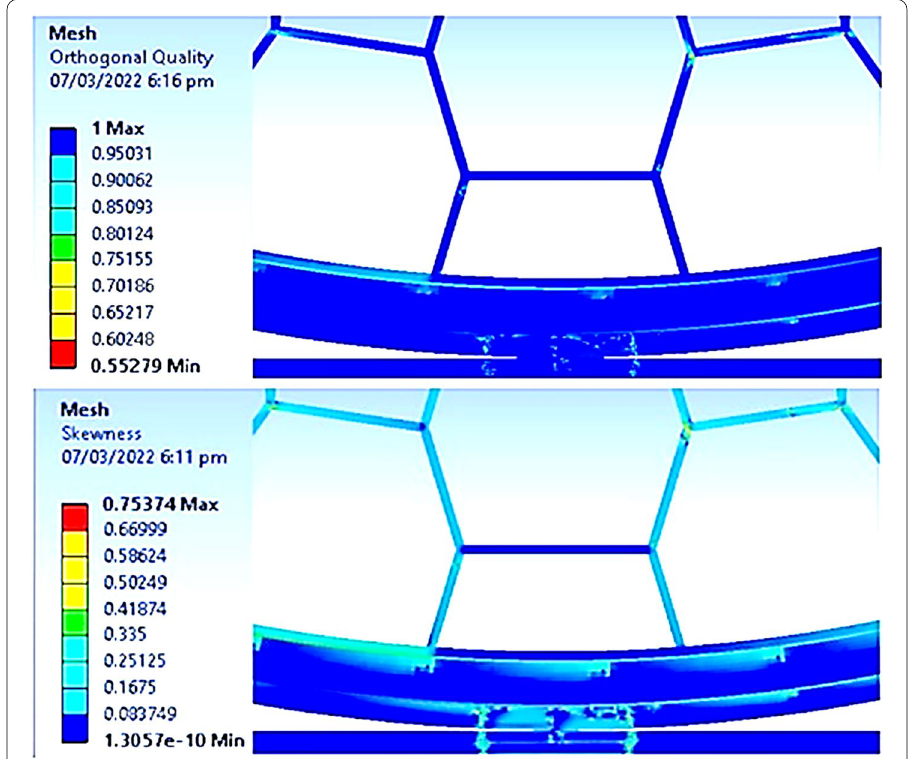
Fig. 8 Refined meshing around the point contact region showing the orthogonal and skewness mesh